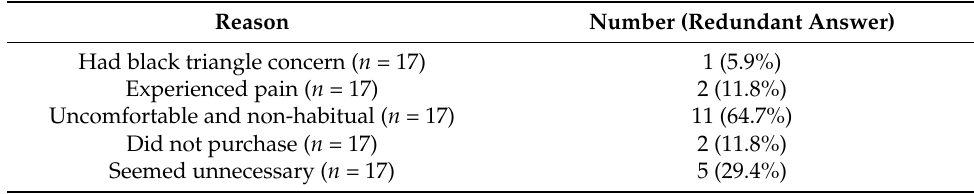
Table 5. Reasons for less use of interdental brushing in the IB-NN group ( n = 17).